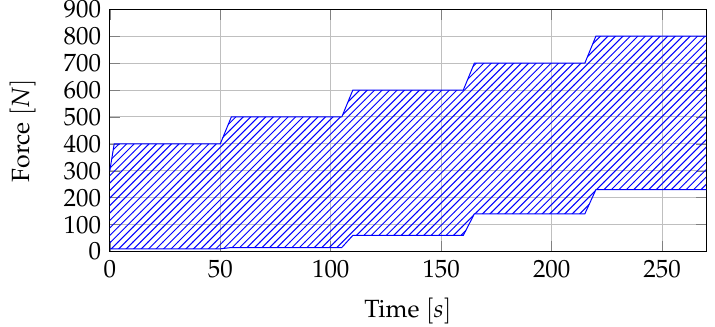
Figure 3. Predefined sequence for the dynamic test in the testing